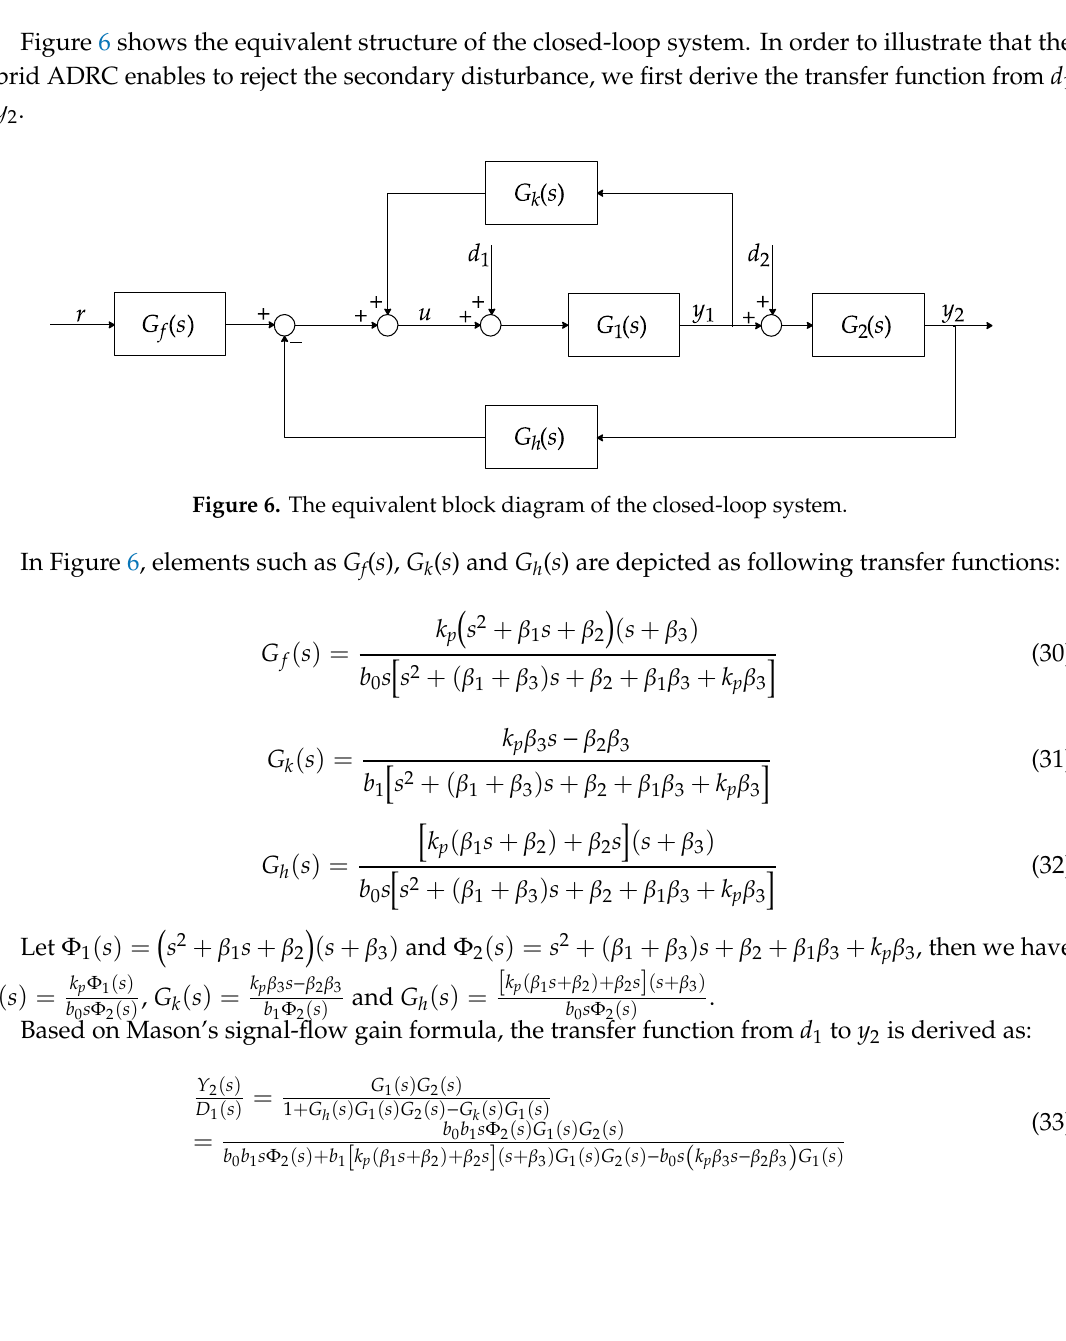
Figure 5. The equivalence from u to y 1 .